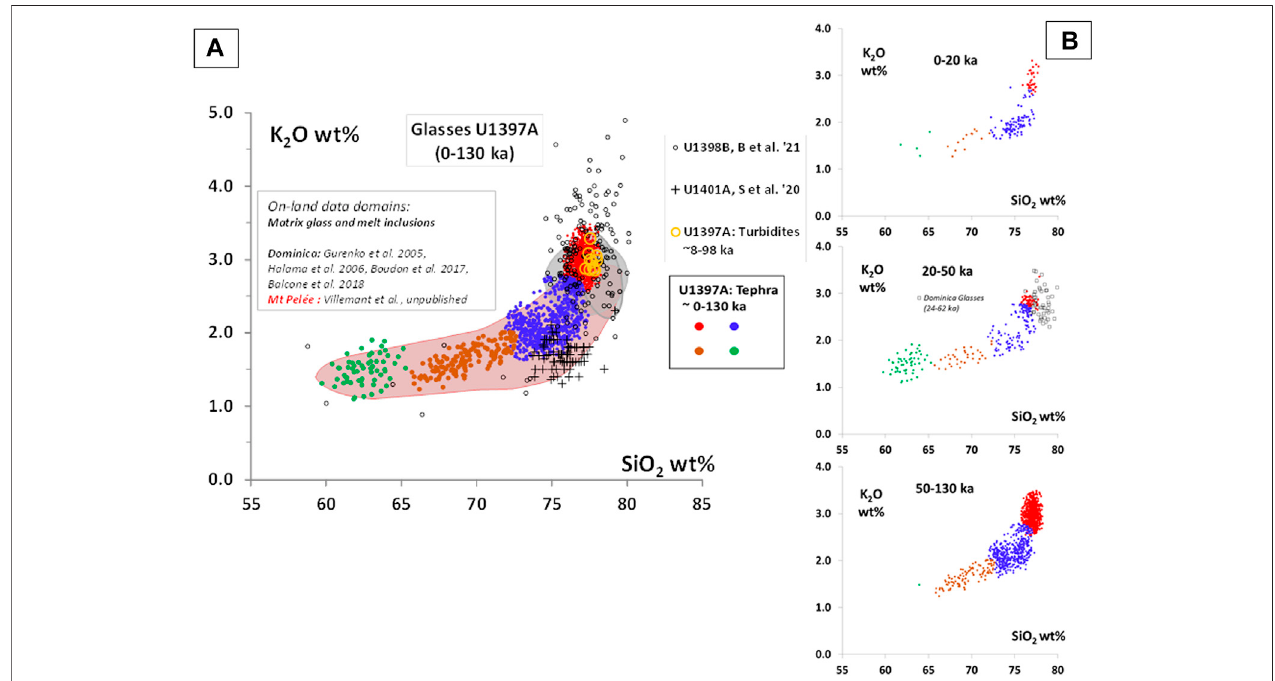
FIGURE10| SiO 2 andK 2 OcompositionsofglassfromcoresoftheIODP340expedition. (A) Comparisonwithon-landsamplesofMtPeléeandDominica.Colored symbols: tephra (dots) and turbidites (open yellow circles) of core U1397A (top 50 m ~ 0 – 130 ka; Villemant et al., unpublished data and Del Manzo et al., in